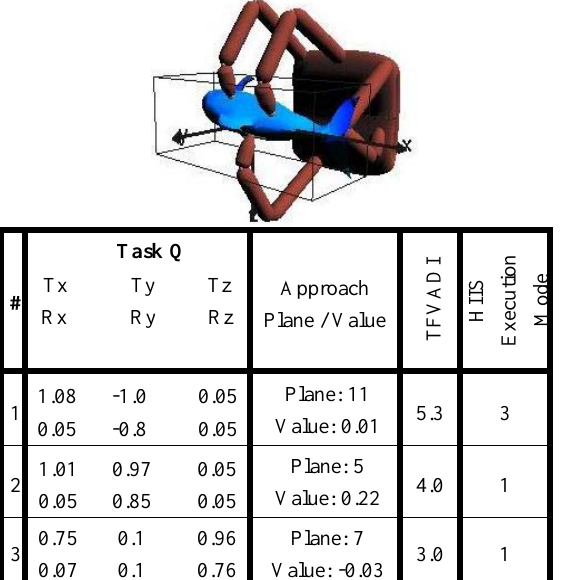
Figure 13 Testing HIIS Learning with a complex